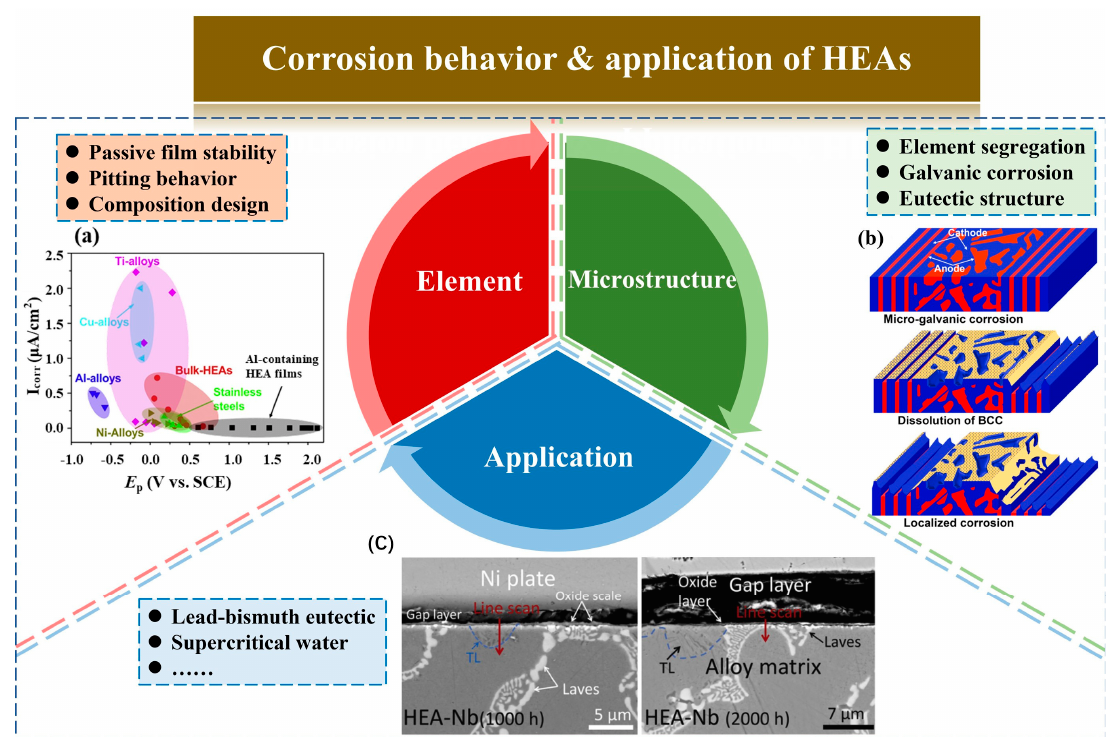
Figure 1. An overview of corrosion behavior and mechanism of HEAs regarding their elements (red area), microstructure (green area), and applications (blue area). ( a ) Passive film stability and pitting behavior for various alloys; ( b ) corrosion mechanism diagram of EHEA in H 2 SO 4 solution; ( c ) SEM results of the cross section of HEAs after LBE corrosion [25–27].